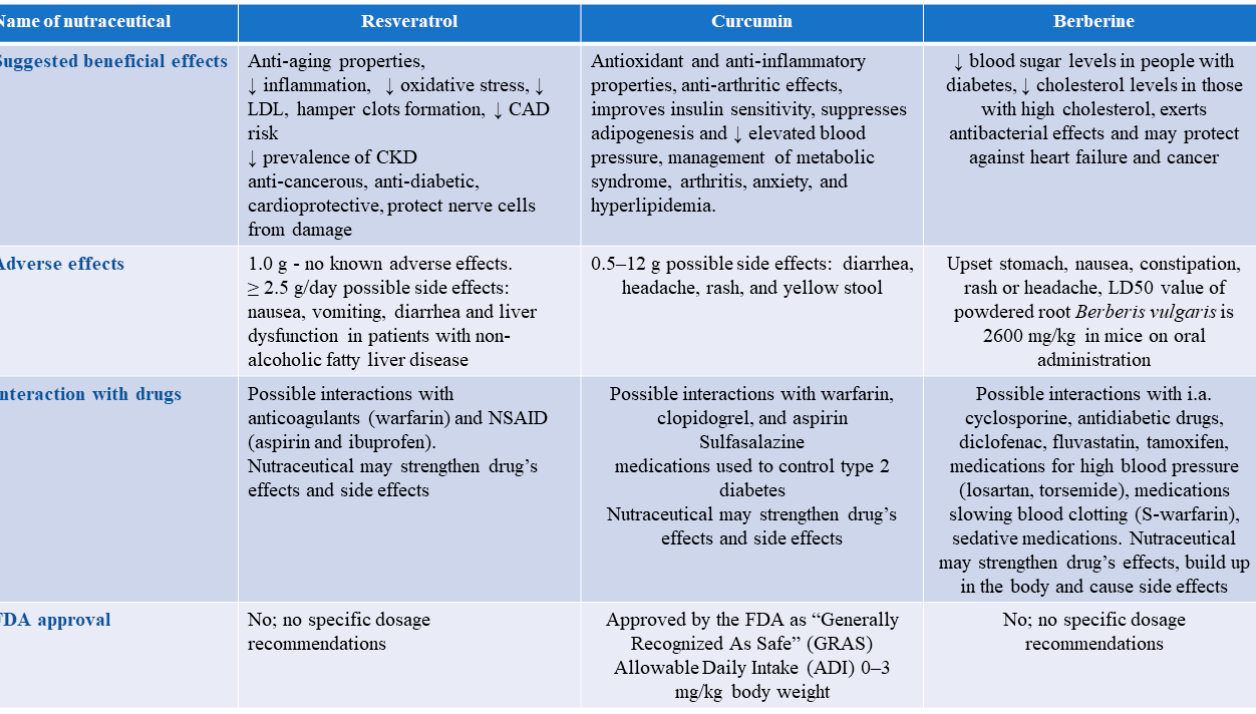
Figure 1. The summary of Resveratrol, curcumin, and berberine effects and interactions.